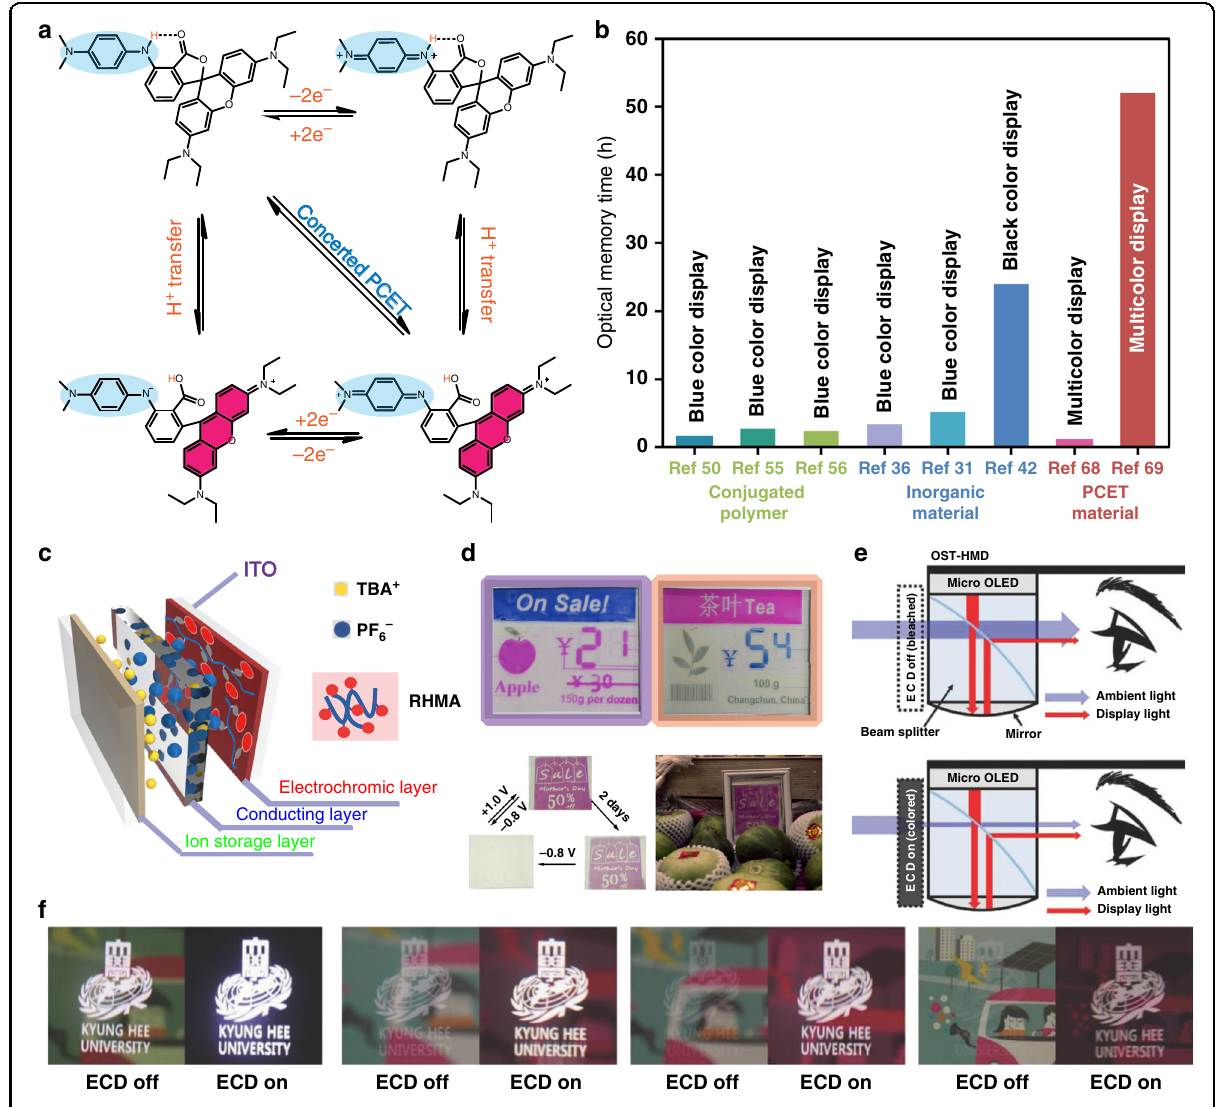
Fig. 4 Unconventional design strategies to promote the development of the bistable electrochromic material/device fi eld. a EC mechanism based on intramolecular proton-coupled electron transfer 69 . b Bistable performance of different types of EC technology. c Structure of a bistable EC device. TBA + , tetrabutyl ammonium ion; RHMA, EC polymer containing the benzoate-lactone-containing fl uoran subunit and the p -phenylenediamine moiety 69 . d Promising applications of bistable EC devices in energy-saving displays — multicolor electronic label shelf and billboard 68,69 . e Mechanism